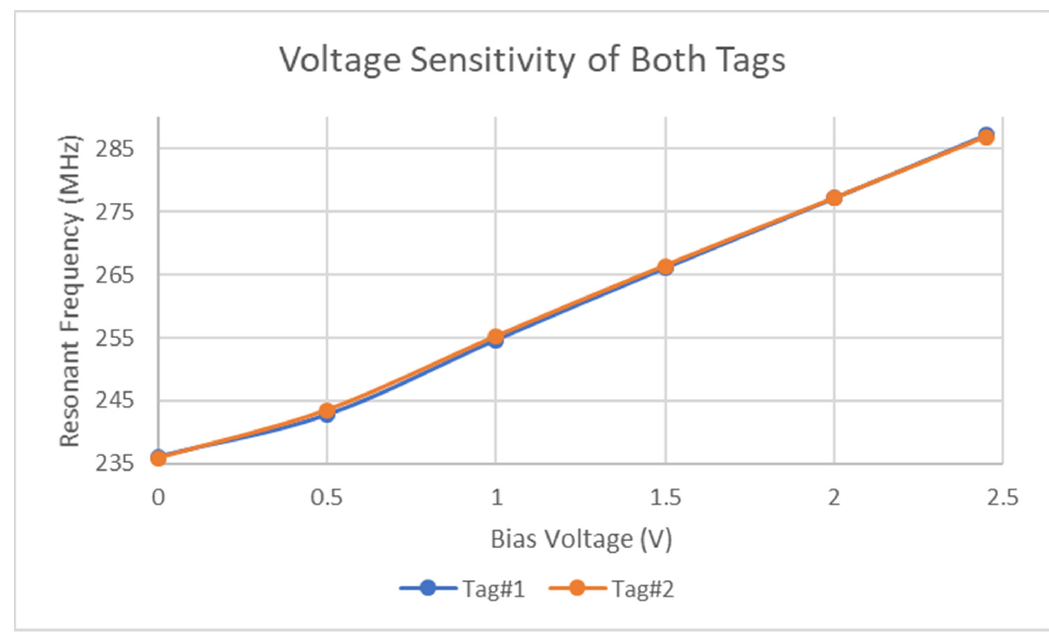
Figure 6. Large voltage sensitivity of tag. Micromachines 2020 , 11 , x FOR PEER REVIEW